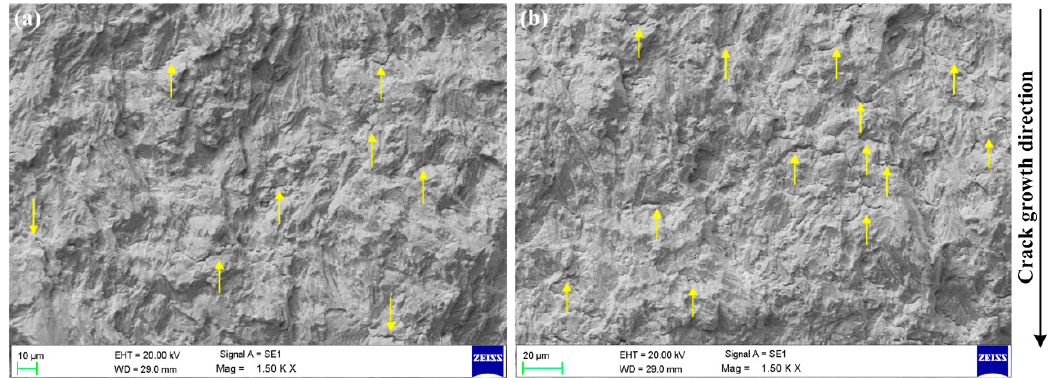
> 1 mm: ( a ) LD1 specimen; ( b ) TD1 specimen.